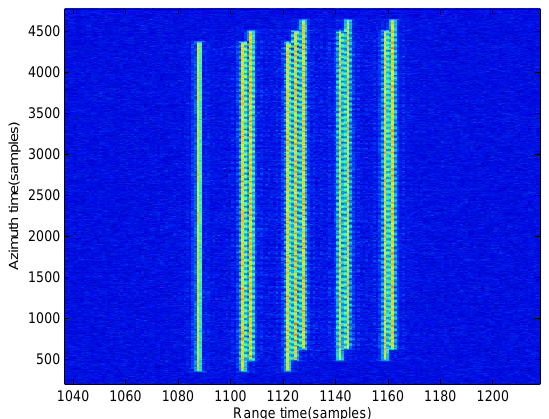
Range time(samples) Figure 7. Range curvature corrected image for the moving Figure 7. Processing results of GMT. (a)Range curvature corrected image for the GMT; (b)Final imaging result.